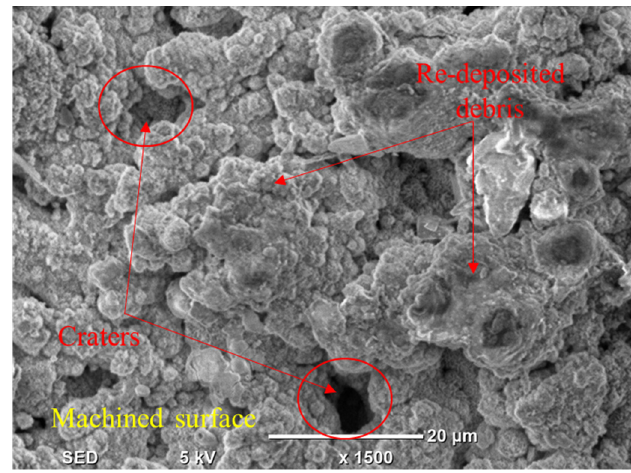
Figure 13. Debris and craters are present on workpiece surface at flushing time equal to 4 µse.